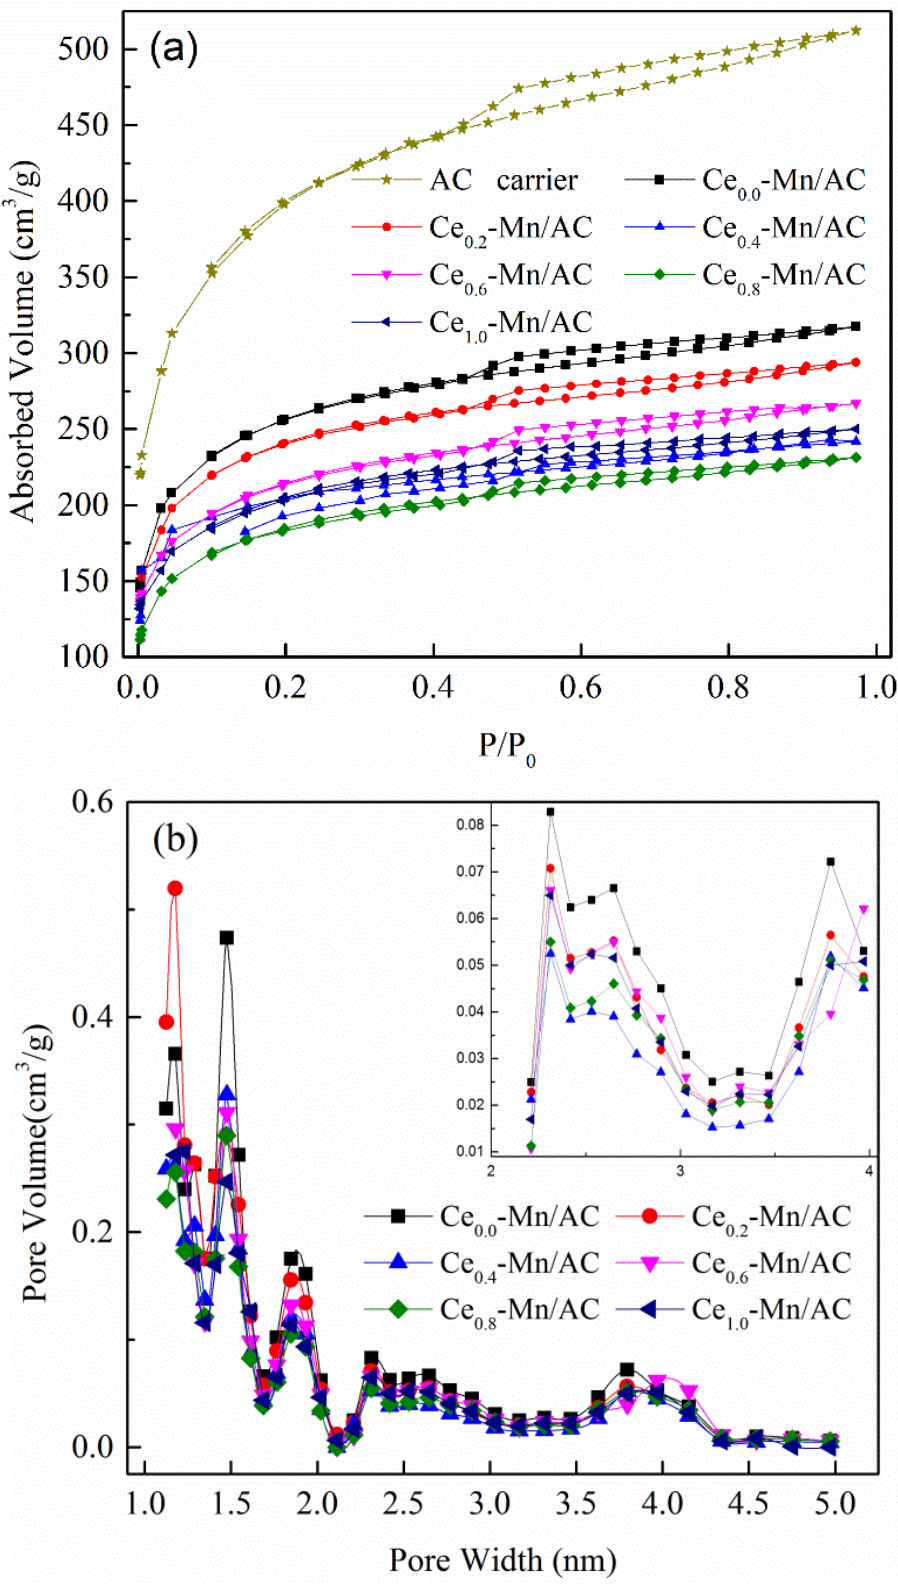
Figure 2. N 2 adsorption–desorption isotherms ( a ) and DFT pore size distributions ( b ) for Table 1. Porous structural parameters of samples.